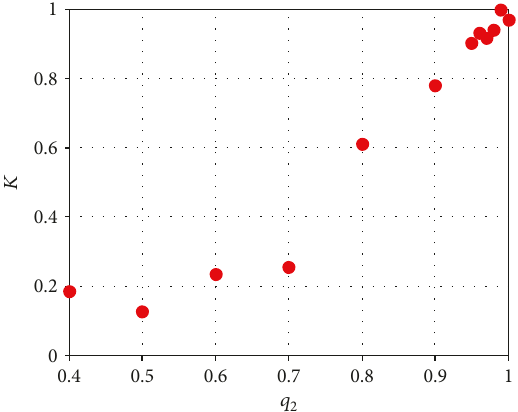
= 0 4 , q = 0 5 , q = 0 6 , 2 2 2